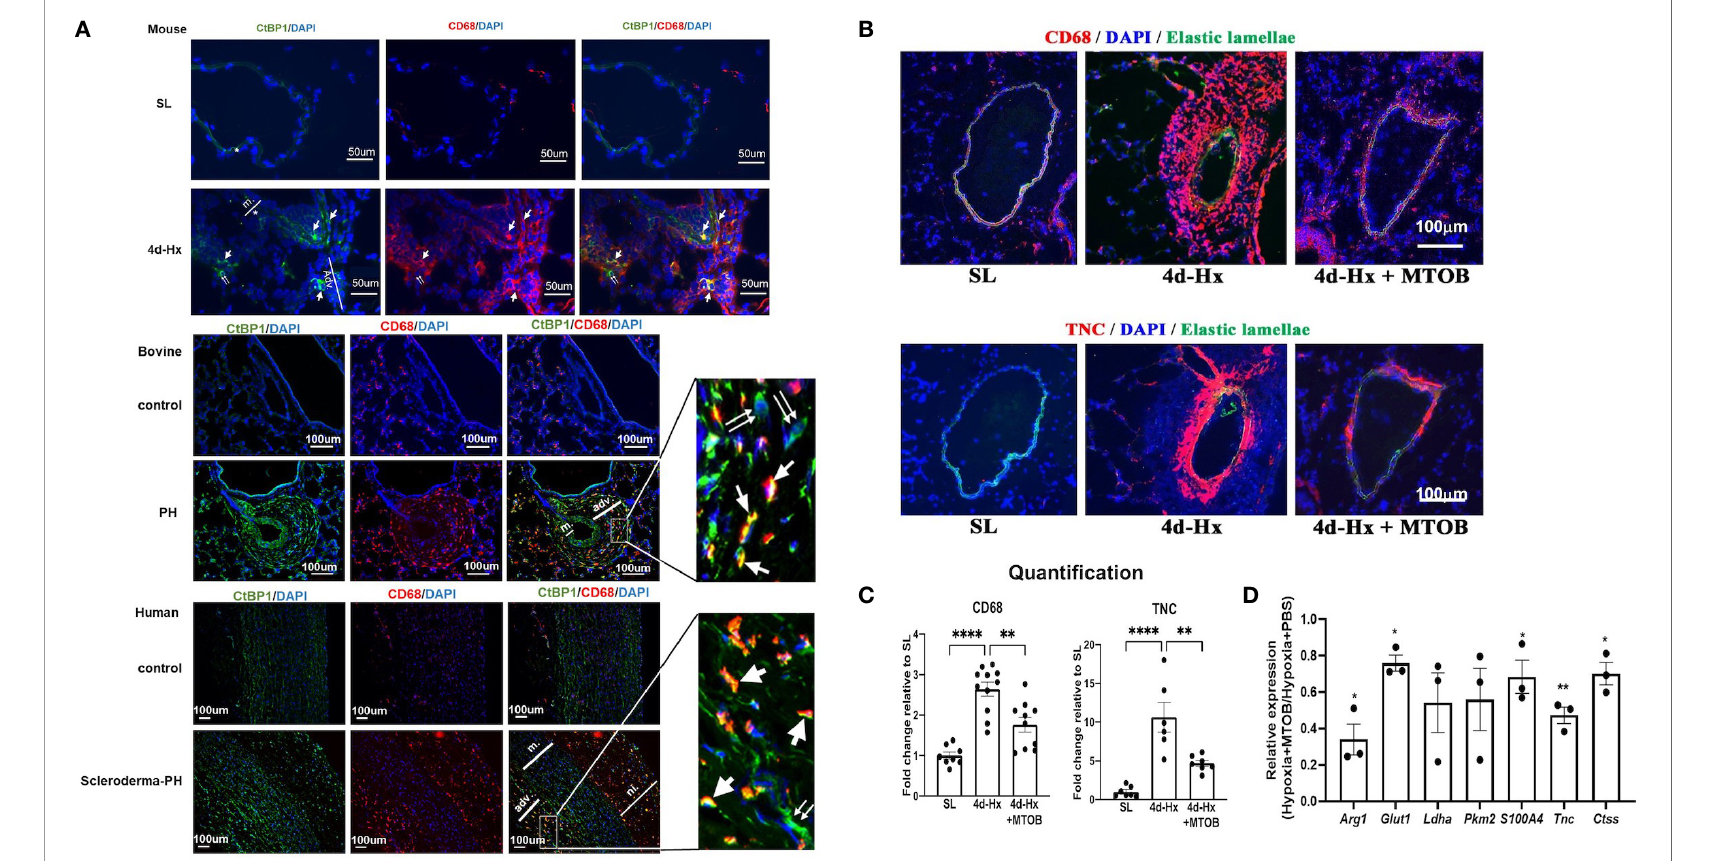
FIGURE 9 | In vivo treatment of hypoxia-exposed mice with the CtBP1 inhibitor, MTOB, inhibited lung interstitial/perivascular macrophage activation. (A) Immuno fl uorescent double staining (green: CtBP1, red: CD68, blue: DAPI, scale bar = 50 m m for mice and scale bar = 100 m m for bovine or human. “ m ” -media, “ adv ” -adventitia, “ ni ” -neointima) demonstrated that CtBP1 protein is overexpressed in the adventitia of 4-day hypoxia-exposed mice, neonatal calves with chronic hypoxia-induced pulmonary hypertension (PH), and human PH patients, but not in their respective controls. Single arrows showed the cells with positive staining for both CtBP1 and CD68. Double arrows showed cells with positive staining for CtBP1 only. (B) Immuno fl uorescent staining of mouse lung sections obtained from sea level (SL) control, 4-day hypoxic (4d-Hx), or 4d-Hx mice treated with MTOB (4d-Hx + MTOB) showed that MTOB decreased in fl ammatory cell recruitment (CD68) and vascular remodeling (TNC). (C) Quanti fi cation of CD68 and TNC staining on lung sections from SL, 4d-Hx and 4d-Hx+MTOB mice. ** p < 0.01, **** p < 0.0001. (D) Lung interstitial/perivascular macrophages were isolated by fl ow cytometry from mice exposed to hypoxia (HX-IM) and treated with MTOB or PBS. Experiments were repeated three times. qPCR showed MTOB decreased the gene expression of Arg1, Glut1, Ldha, Pkm2, S100A4, Tnc , and Ctss in interstitial/perivascular macrophages exposed to hypoxia. Data is represented as fold change relative to PBS treated hypoxic mice and is displayed as mean ± sem. * P < 0.05, ** P <